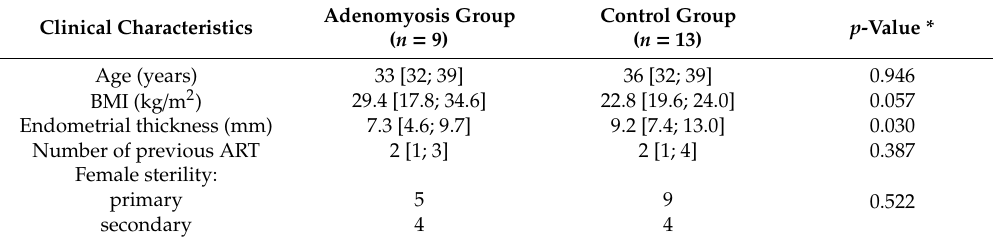
Table 4. Comparison of study groups. Values reported as median (95% confidence interval (CI) for median). Clinical Characteristics